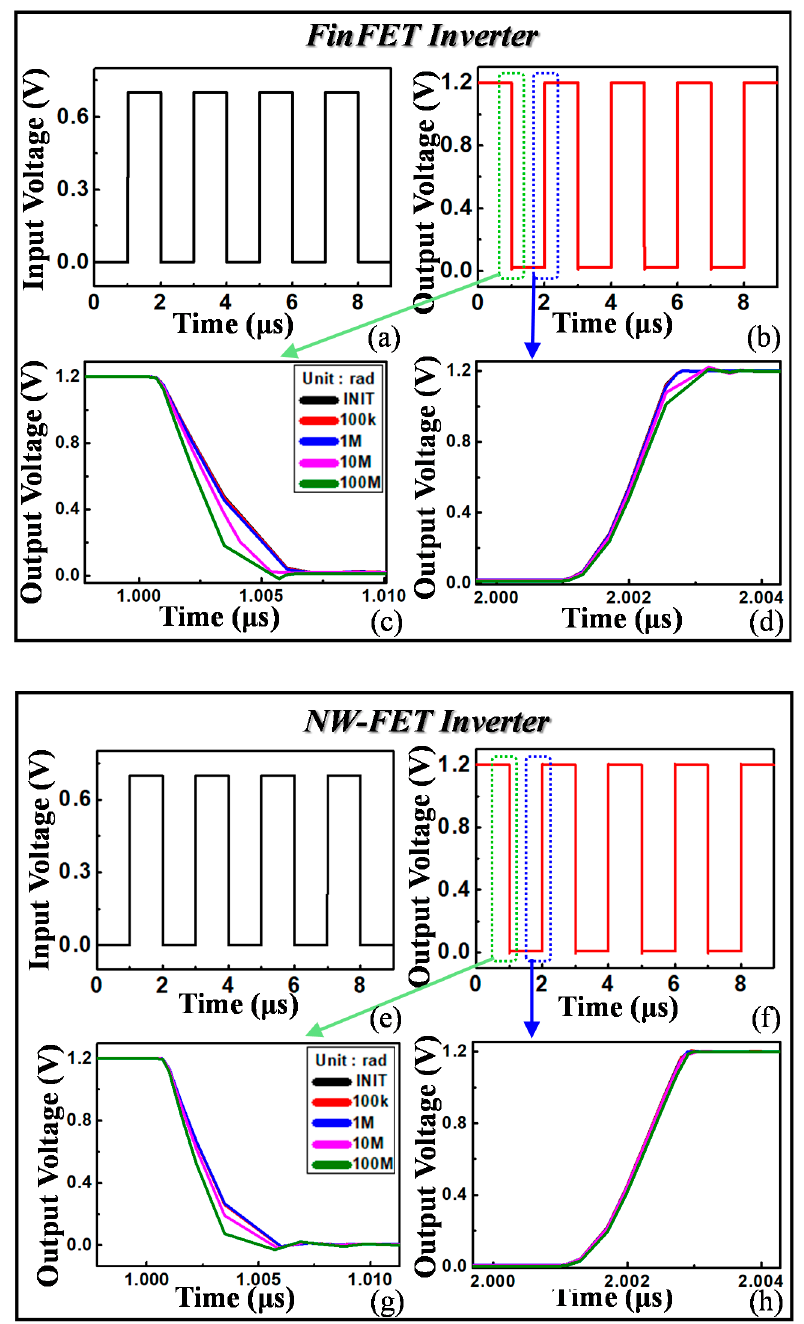
Figure 6. FinFET and NW-FET inverter operation characteristics according to the accumulated radiation dose. ( a , e ) inverter input pulse; ( b ) FinFET inverter output for each total dose; ( c ) FinFET inverter operation of falling edge; ( d ) FinFET inverter operation of rising edge; ( f ) NW-FET inverter output for each total dose; ( g ) NW-FET inverter operation of falling edge; ( h ) NW-FET inverter operation of rising edge.